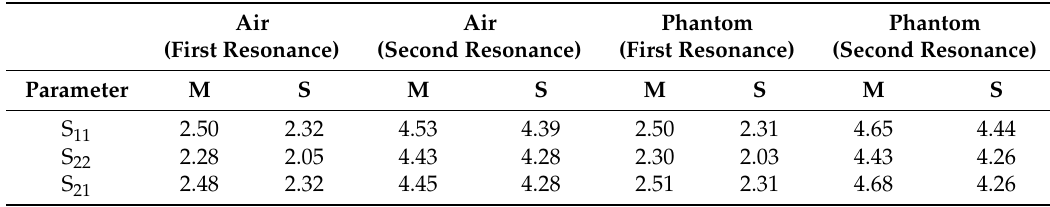
Table 2. Resonance frequencies (GHz) (M: Measurement, S: Simulation).